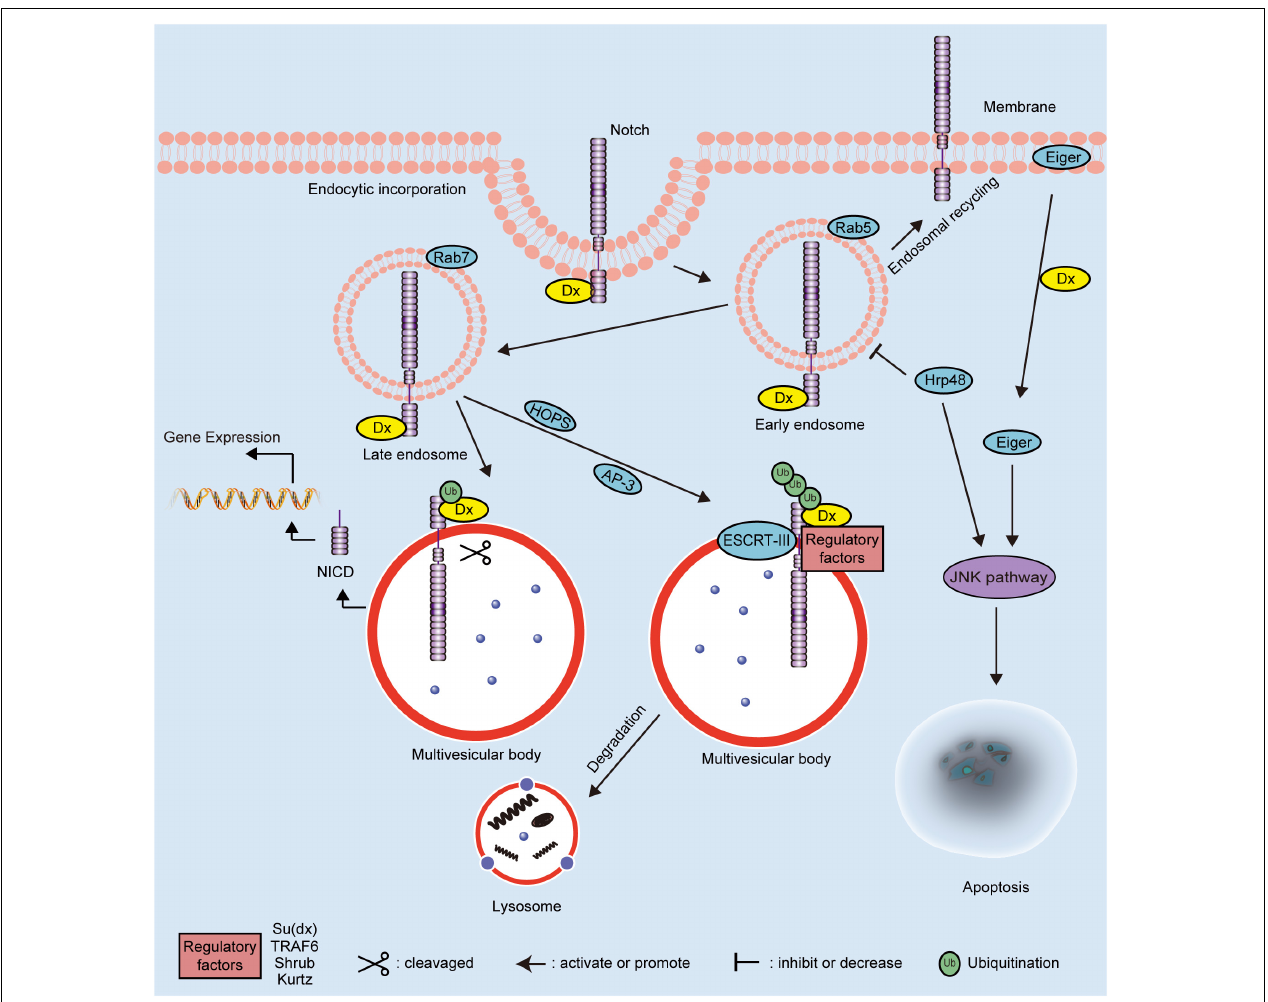
FIGURE 2 | Schematic diagram showing the molecular mechanisms of Dx in Drosophila . The regulation mechanisms of Dx on the Notch signaling pathway depend on the ubiquitination pattern of the Notch receptor. Dx activates the endocytosis of Notch independent on the canonical ligands. The endosomal maturation is initiated by the HOPS complex and converted from Rab5 to Rab7. Interaction with the AP-3 complex promotes Notch targeting to the late-endosomal and lysosomal vesicle membranes. Dx functions as a positive modulator of the Notch signaling pathway when the Notch receptor is monoubiquitinated. The extracellular domain of monoubiquitinated Notch is removed and degraded following cleavage. Then, the NICD of Notch is released to activate the downstream gene expression. However, Dx acts as a negative regulator of the Notch signaling pathway when Notch is polyubiquitinated by Dx and regulatory factors, including Su(dx), TRAF6, Shrub, and Kurtz. The polyubiquitinated Notch is transferred into multivesicular body via ESCRT-III and degraded via the endosome/lysosome pathway. Dx also influences the JNK signaling pathway to induce apoptosis via interacting with Hrp48 or Eiger. NICD, intracellular domain; Dx, Deltex; TRAF6, tumor necrosis factor receptor associated factor 6; AP-3, adaptor protein-3; HOPS, homotypic fusion and vacuole protein sorting; ESCRT-III, endosomal sorting complex required for transport-III; Hrp48, heterogeneous nuclear ribonucleoprotein 48; JNK, Jun N-terminal Kinase; Su(dx), Suppressor of Deltex; Ub,